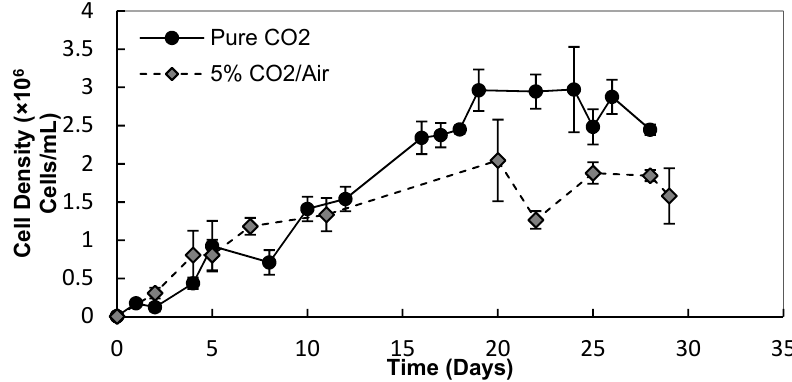
Figure 4. Effect of CO 2 supplementation on cell density (×10 6 cell/mL) of P. cruentum at optimum temperature (20 °C) and light intensity (140 µE m − 2 s − 1 ) and nitrogen concentration (0.075 g